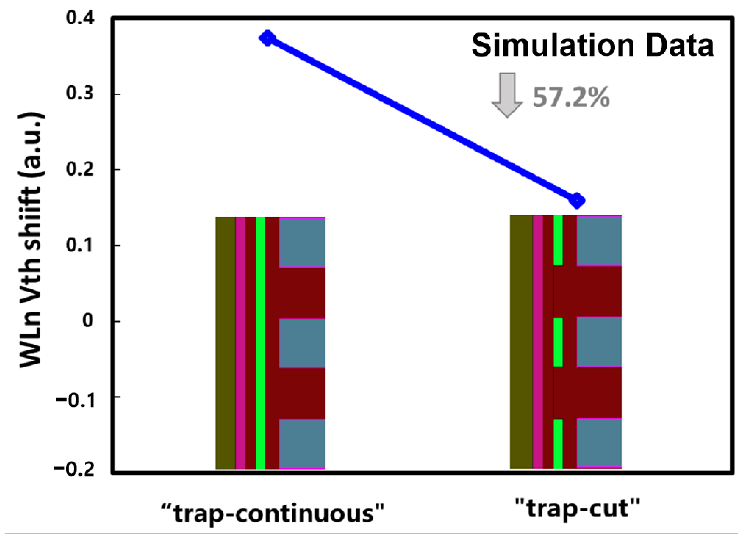
Figure 3. The z-interference comparison of the “trap-continuous” and” trap-cut” structures.